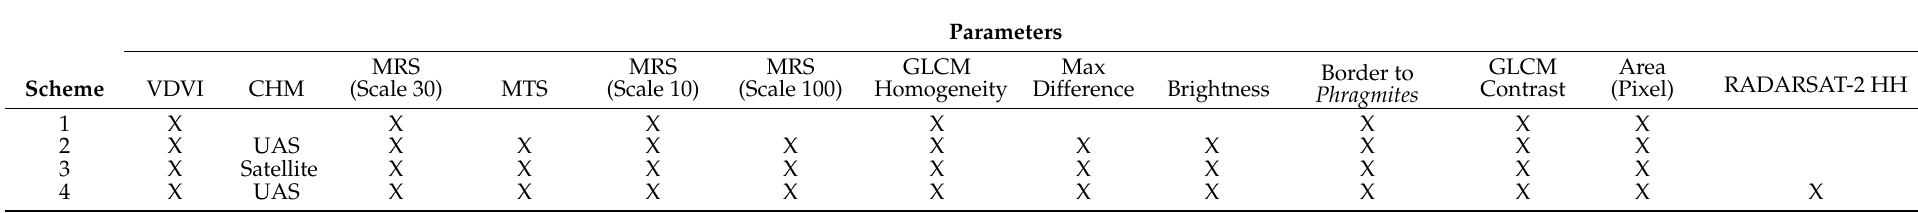
Table 2. Layers and classification parameters used for each image classification scheme within eCognition. The first column identifies the classifier. The second column represents if the VDVI layer was used to identify vegetation. Column three represents the use of a CHM and the data source used for its creation. The remaining columns identify the parameters used to classify Phragmites , organized based on the order of operations within the classifier. Scale parameters for the multi-resolution segmentations (MRS) are provided. All multi-resolution segmentations used a shape parameter of 0.3 and a compactness parameter of 0.5. The maximum threshold for the multi-threshold segmentation (MTS) was 4 m and the minimum threshold was 2 m. Each scheme used the RGB bands of the UAS imagery. Schemes 2–4 included a CHM, while only Scheme 4 included the RADARSAT-2 HH polarization. The CHM and RADARSAT-2 HH polarization are used in the calculation of GLCM homogeneity and contrast if the layer is present in the